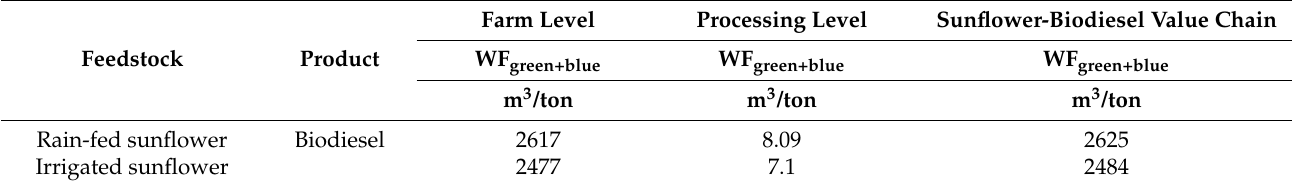
Table 6. Total water footprint throughout the sunflower-biodiesel value chain.